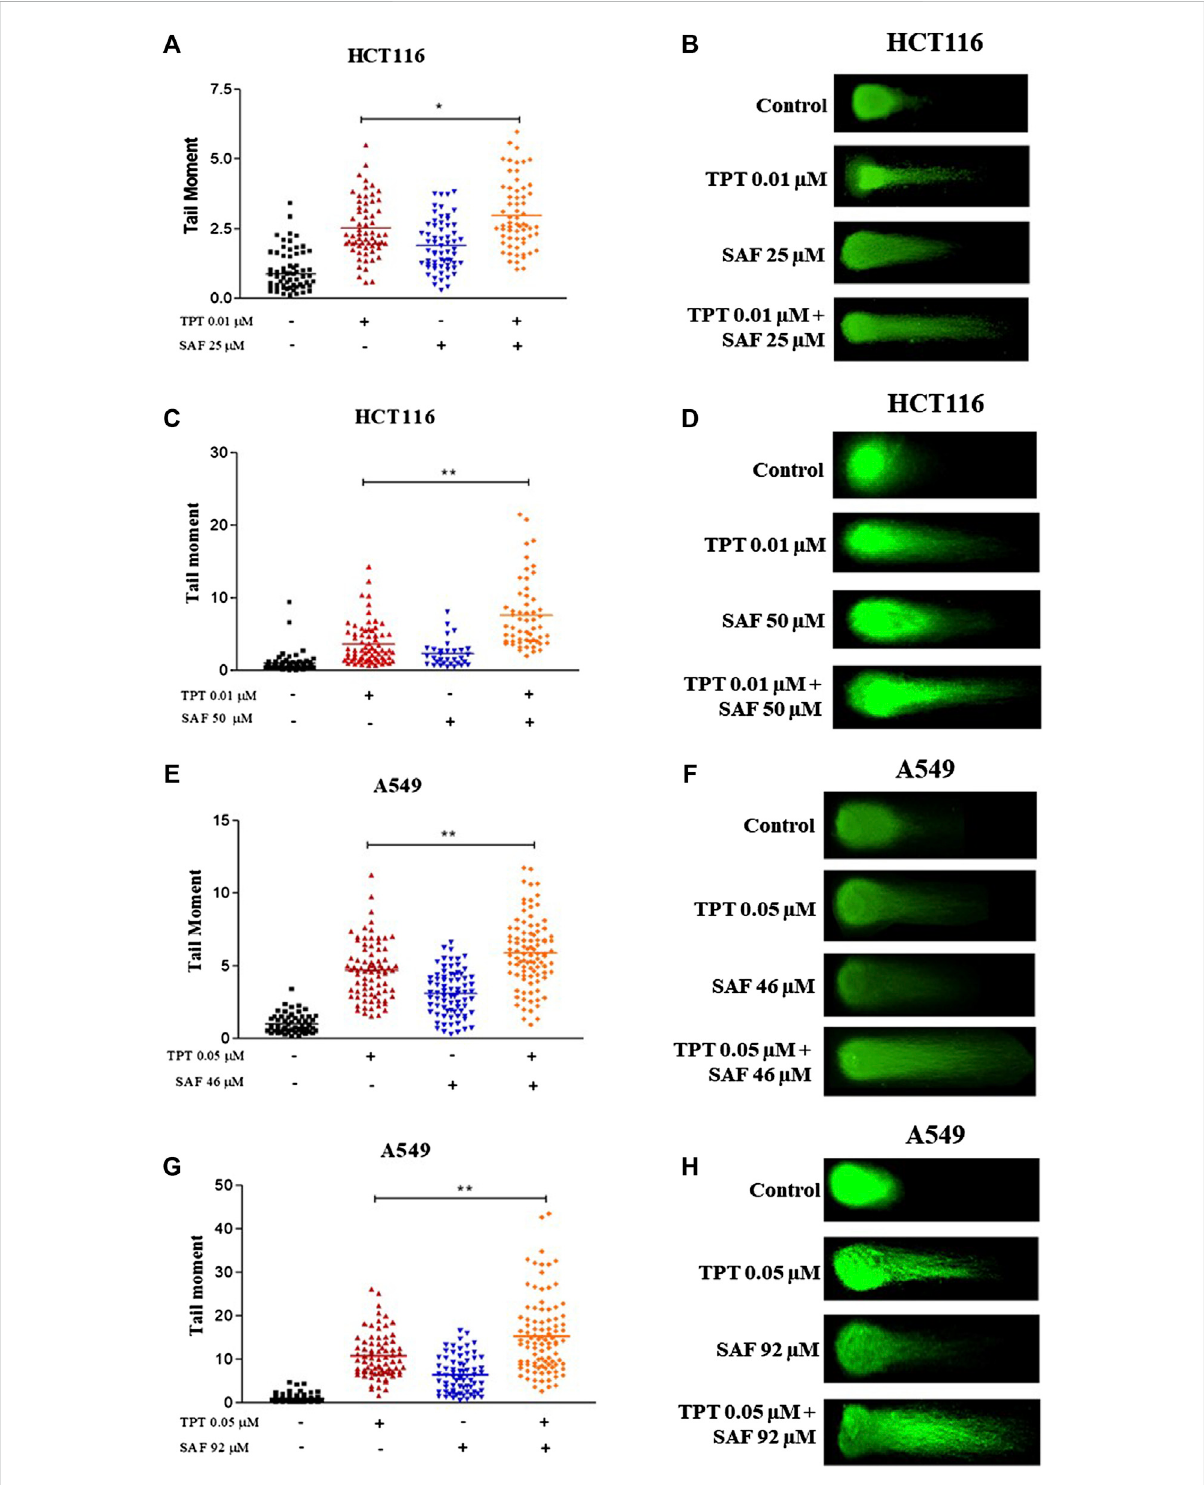
FIGURE 2 Neutral comet assay of HCT116 and A549 cells treated with SAF IC25/IC50 before TPT IC50 treatment for 24 h. (A – D) Tail moment and fl uorescence microscopic imagesofHCT116 cells treated with SAFIC25/IC50,24 hbefore TPT 0.01 µM, the combined treatment was incubated for 24 h. (E – H) Tailmomentand fl orescencemicroscopicimagesofA549cellstreatedwithSAFIC25/IC50,24 hbeforeTPT0.05 µMandthecombined treatment was incubated for 24 h. The means ± SEM of at least two independent experiments are shown. * p < 0.05, ** p < 0.005 vs TOP